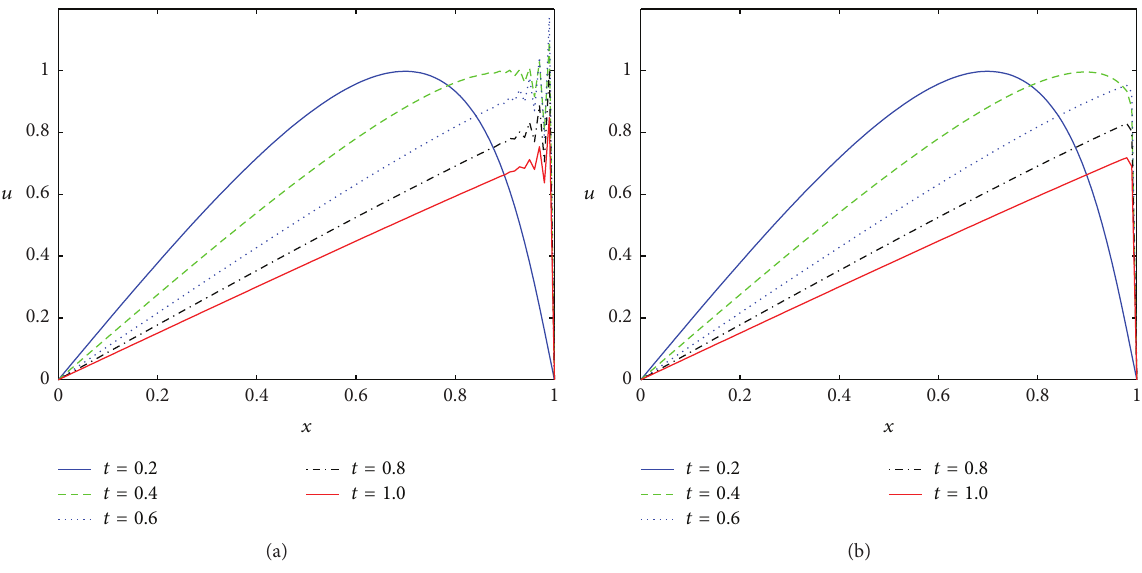
Figure 5: The numerical solutions of Re = 10 3 via EFG and VMEFG, respectively. (a) is obtained by EFG and (b) is obtained by VMEFG.